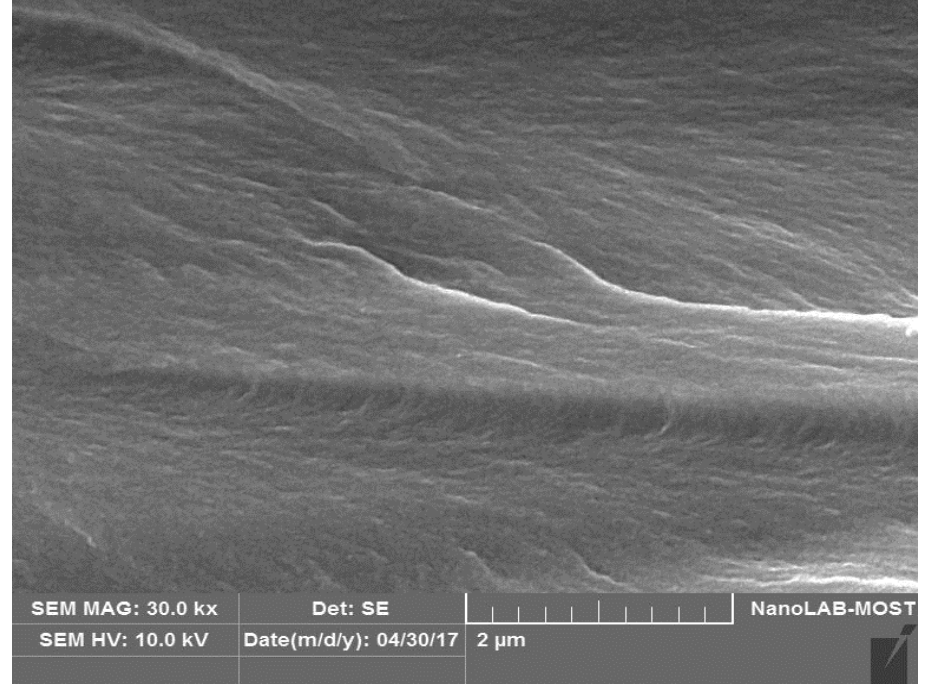
Fig. 8: SEM morphology of fracture surface for neat (UPE). at the magnification of